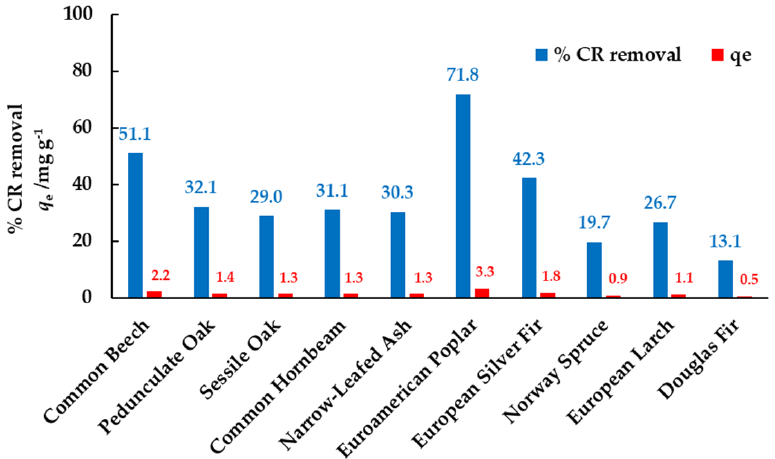
Figure 2. Screening of waste biomass of different wood species as biosorbents for CR removal from aqueous solutions ( γ CR = 50 mg dm − 3 , γ biosorbent = 10 g dm − 3 , t = 360 min, T = 298.15 K, v = 150 rpm).